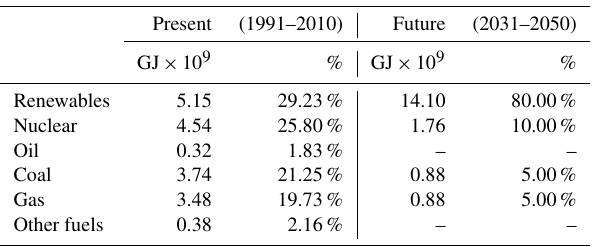
Figure 3. Energy mix in the REN80 scenario for the year 2050. Table 1. Annual energy production (in billions of GJ) over Europe from different sources and their contributions to the energy mix in the present and REN80 scenarios.